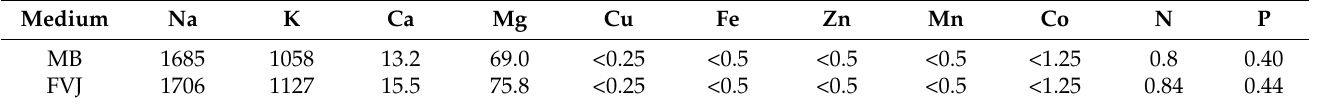
Table 1. Composition of modified Bristol and the mixture of fruit and vegetable